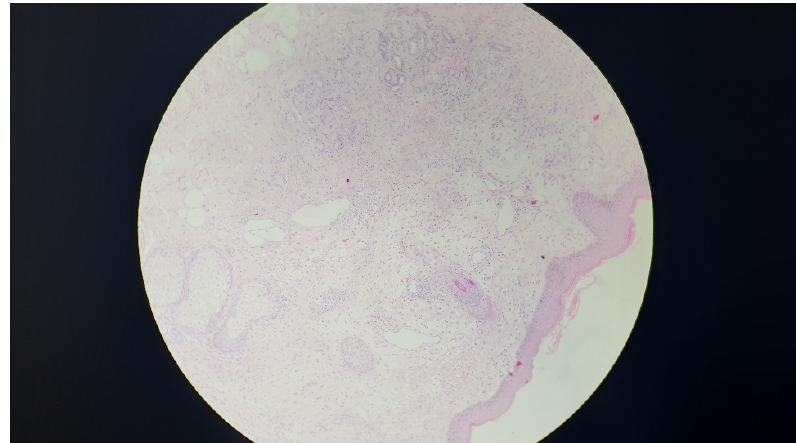
Figure 1. Biopsy of the cheek nodule. A histologic examination revealed a moderately well-defined granuloma in the superficial and deep dermis mainly composed of giant cells. Some eosinophils, histiocytes, and lymphocytes can be observed in the lesion.